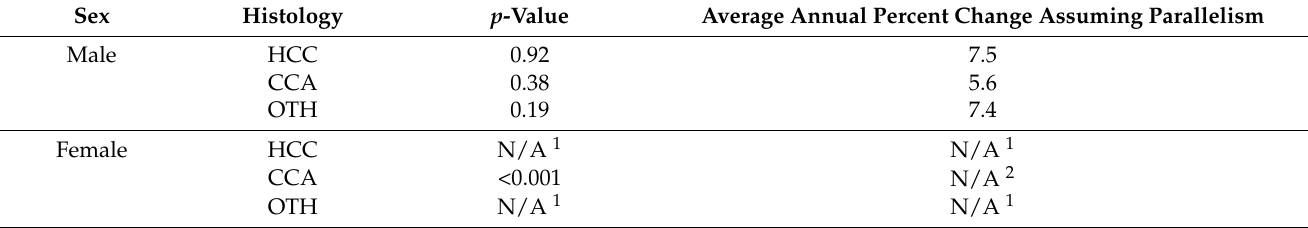
Table A2. Results of Joinpoint parallelism tests for trends before and after imputation among histology and sex